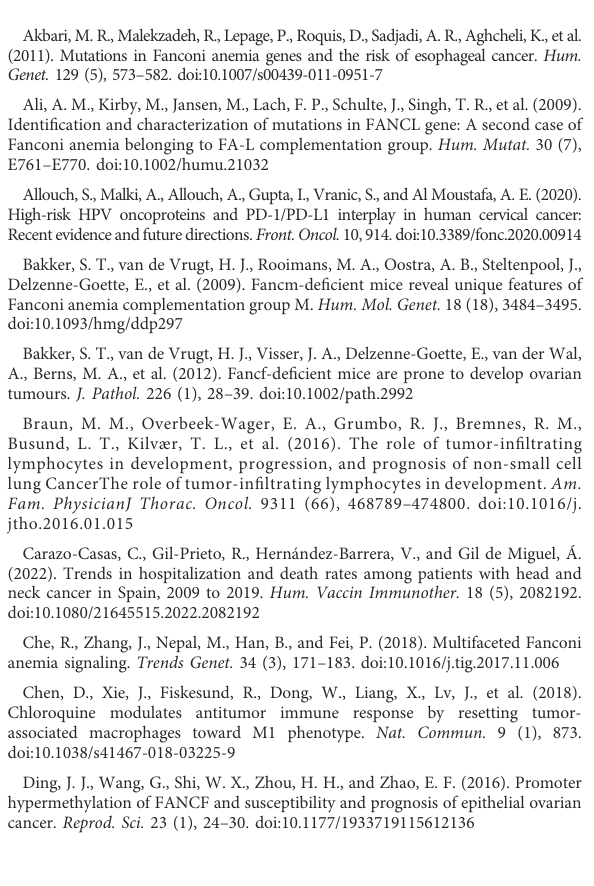
SUPPLEMENTARY FIGURE S1 Gene set enrichment analysis of FANCE expression in cancers. The top 5 most relevant signaling pathways in the KEGG dataset were displayed. SUPPLEMENTARY FIGURE S2 Histology of liver, spleen, stomach, kidney, ovary, and skin tissues of Fance − / − , Fance+/ − , and Fance+/+ female mice cohort and found no signi fi cant abnormalities. All scale label = 100